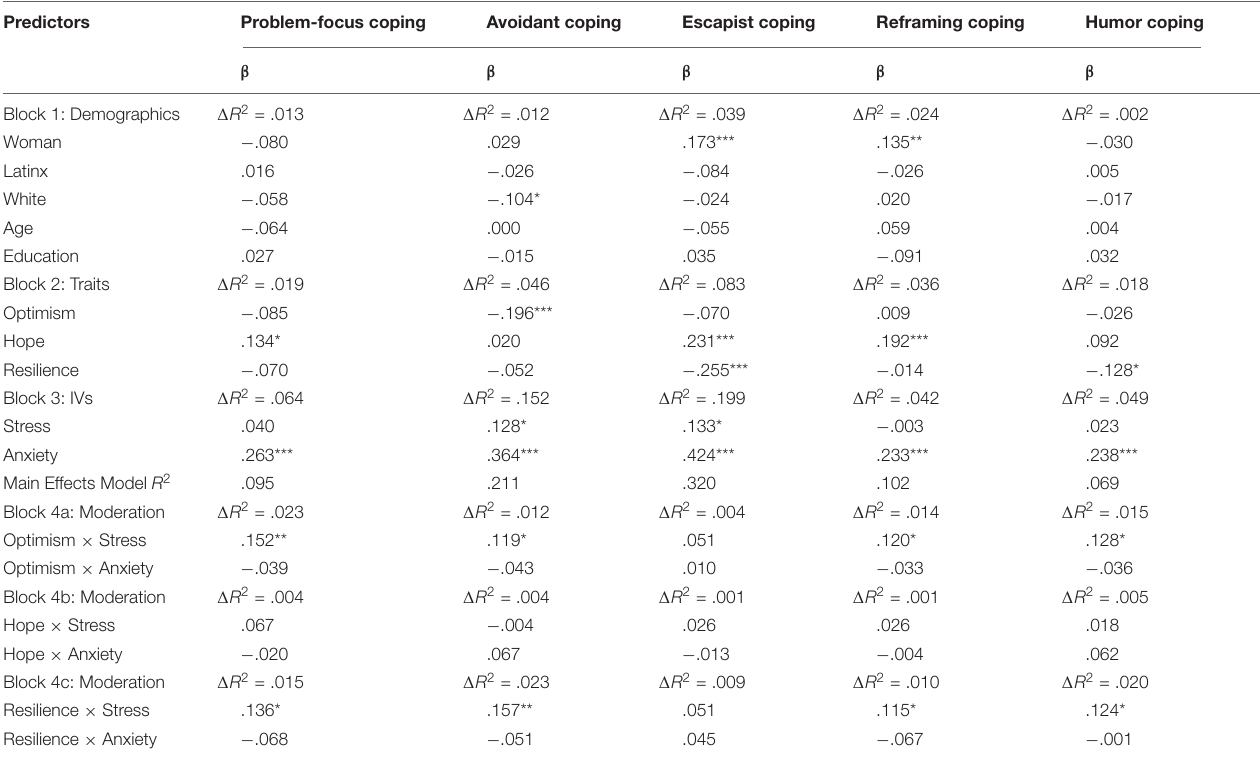
TABLE 5 | Associations of stress and anxiety with media coping.